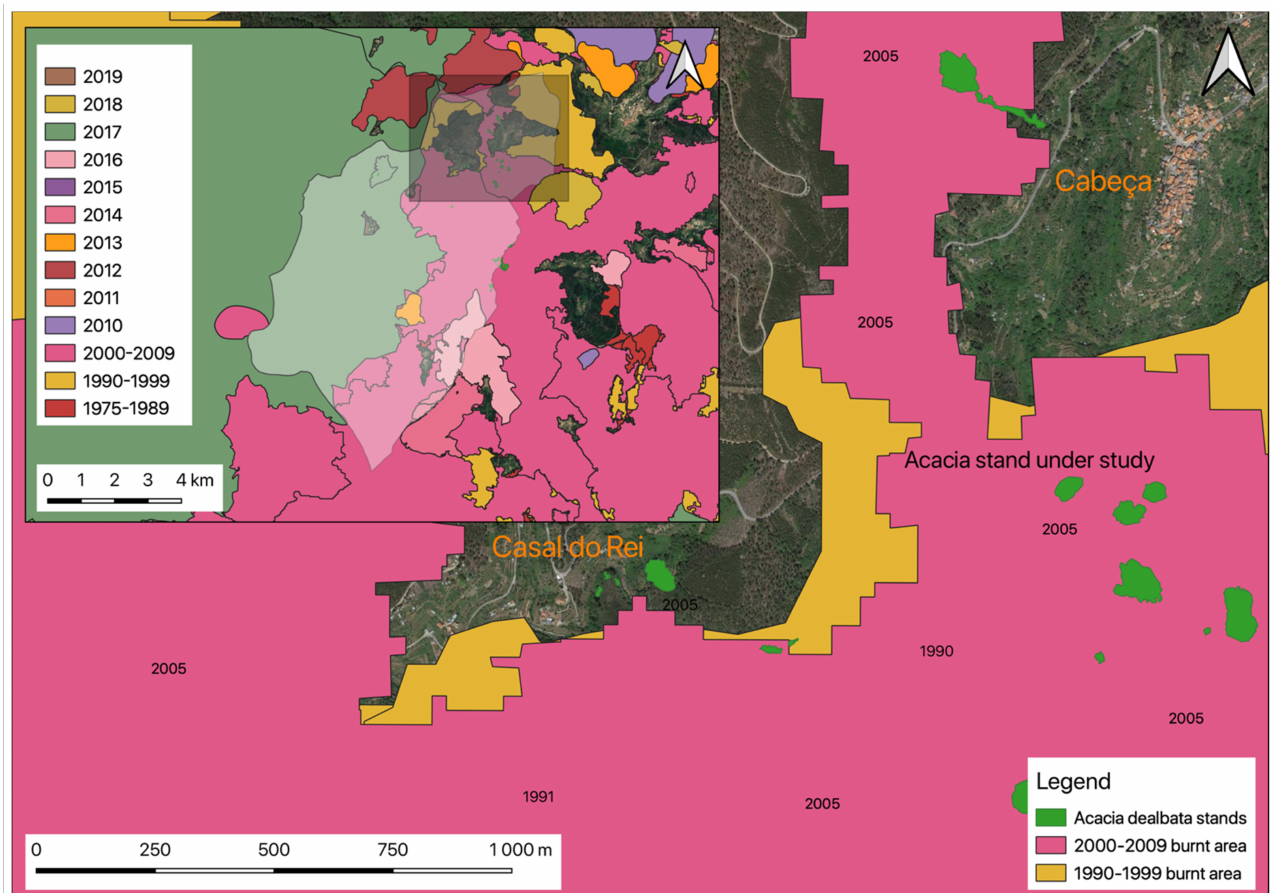
Figure 9. Overlapping of the burnt areas in 1975–2019 in Uni ã o de Freguesias de Vide e Cabeça. 3.3. The Productivity of A. dealbata in the Casal do Rei Region